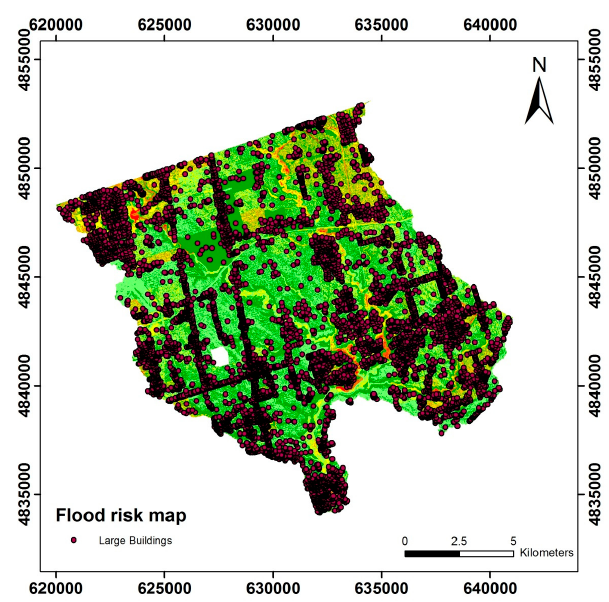
Figure 13. Large buildings superimposed on the Flood Risk map.